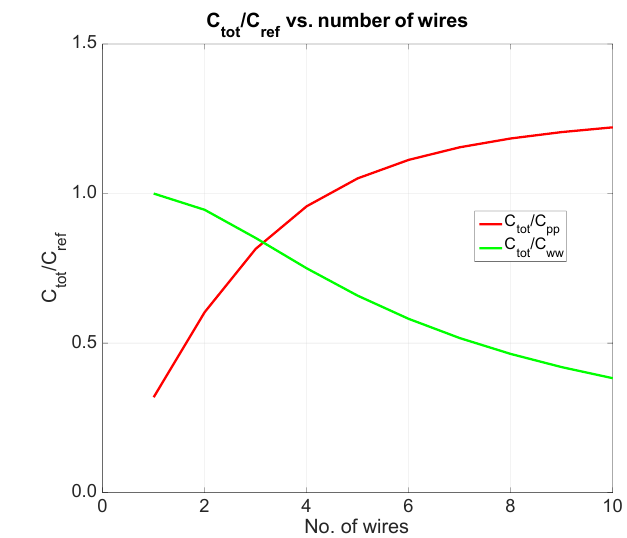
Figure 2. Relative capacitance versus the number of wires, where 10 represents a completely closed layer (Shemelya et al.,